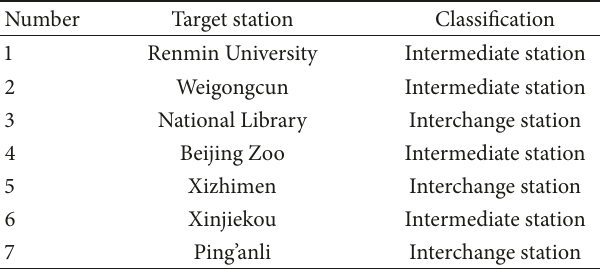
Table 2: The selected stations and their